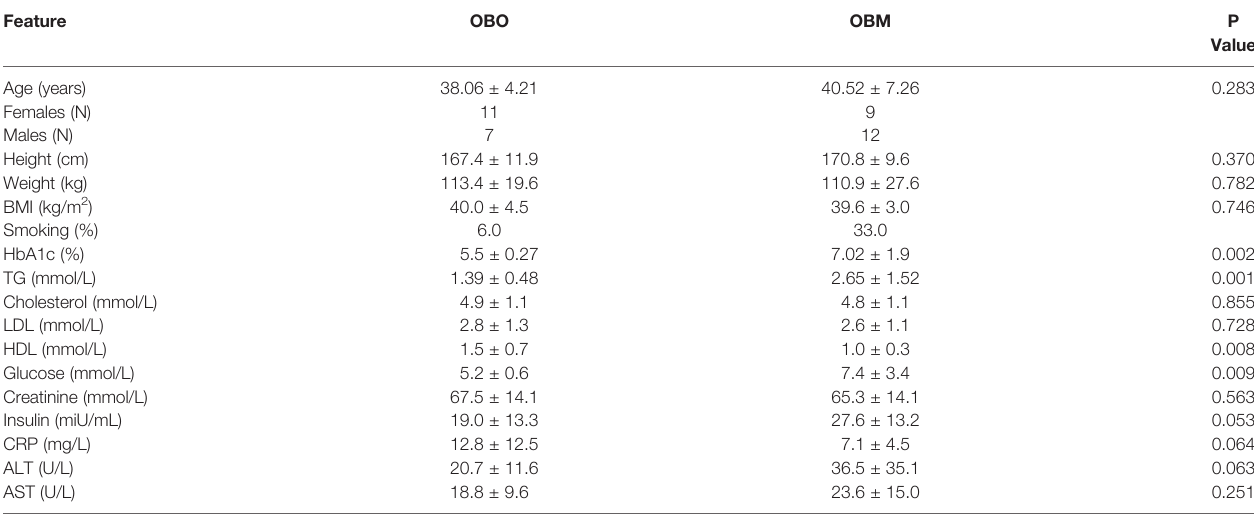
TABLE 1 | Clinical and biochemical traits of the study subjects.